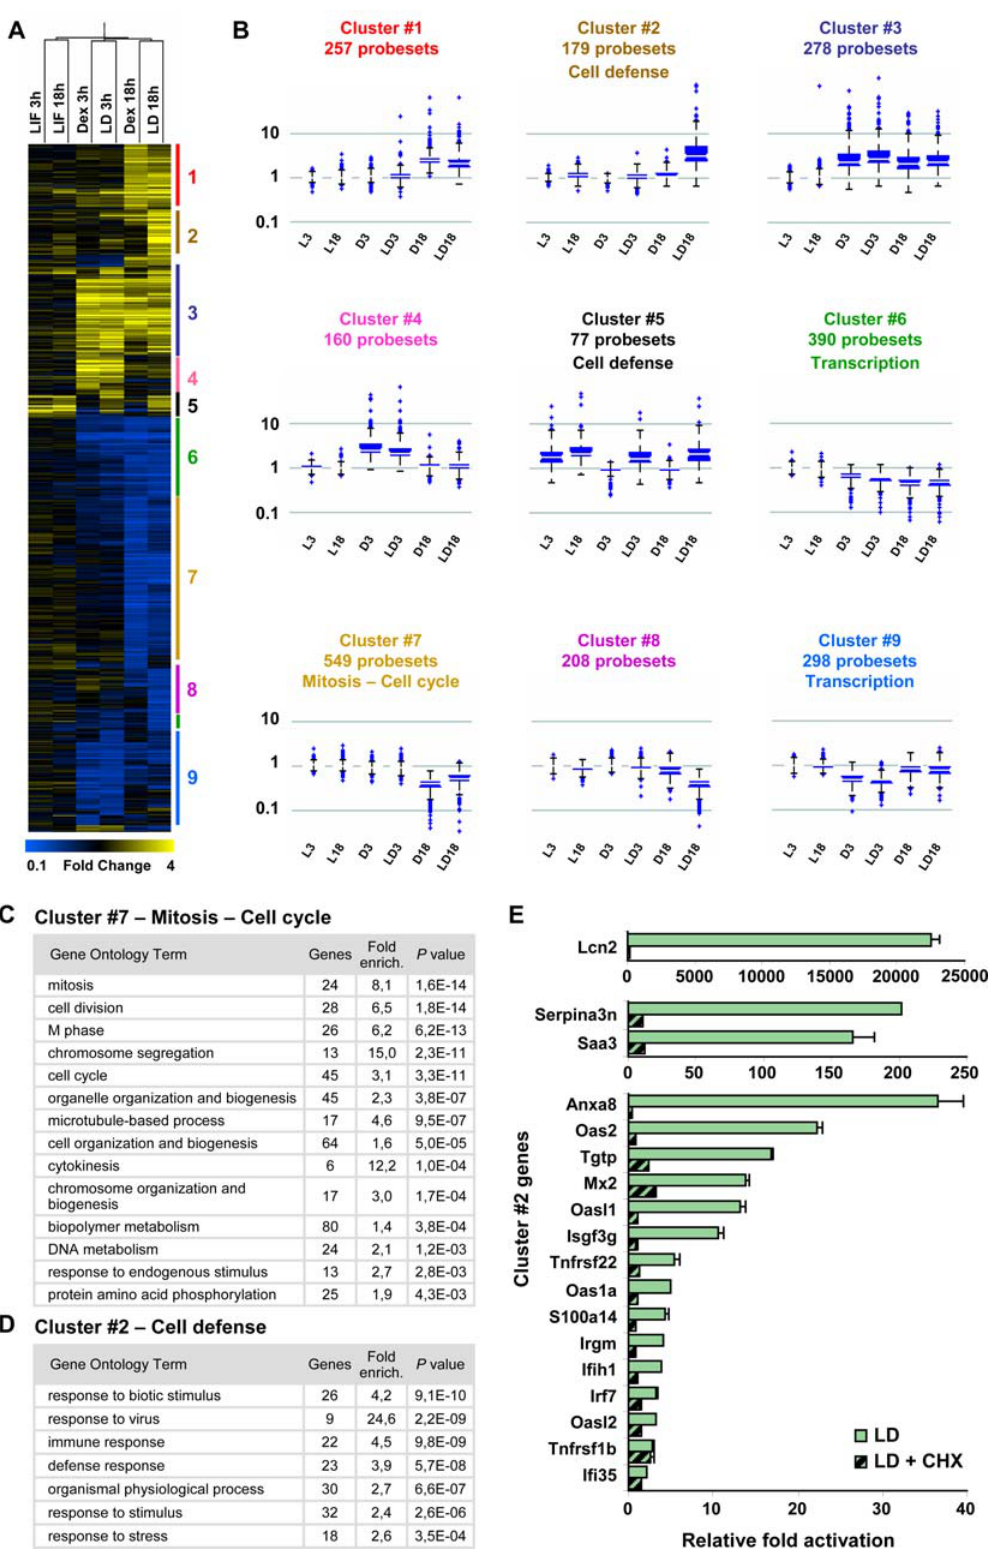
Figure 5. Clustering analysis of LIF and Dex regulated genes. A) Heat map representation of gene clustering identified by global analysis of the expression profiling dataset. The clustering was performed with GeneSpring GX 7.3 using Smooth correlation. B) Box plot representation of Smooth correlation K-means clustering of hormone regulated genes. The analyses required a minimum of 9 clusters in order to represent the different subgroups of genes that were found to be significantly associated. The list of genes in each cluster is presented in Table S3. C) Gene Ontology distribution of genes from cluster # 7 that are repressed by Gc at 18 h of treatment, irrespective of the presence of LIF; these genes are